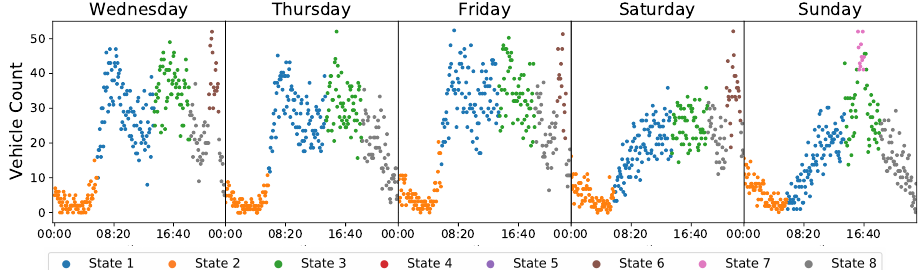
Figure 4. Scatter plots for vehicular density counts. Each colour represents a specific state that the respective observations was clustered into. Morning and evening traffic peaks on weekdays are clustered into state 1 (blue) and state 3 (green), respectively. Traffic caused by evening baseball games near 23:00 (Wednesday, Friday and Saturday) have been clustered into state 6 (brown), whereas traffic peaks caused by afternoon games at about 16:30 (Sunday) were clustered into state 7